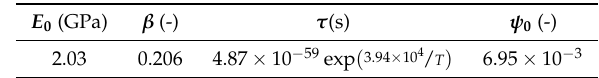
Table 4. Parameters describing the viscoelasticity of the artificial stone and its dependence on temperature, as obtained from the fit of the relaxation curves.